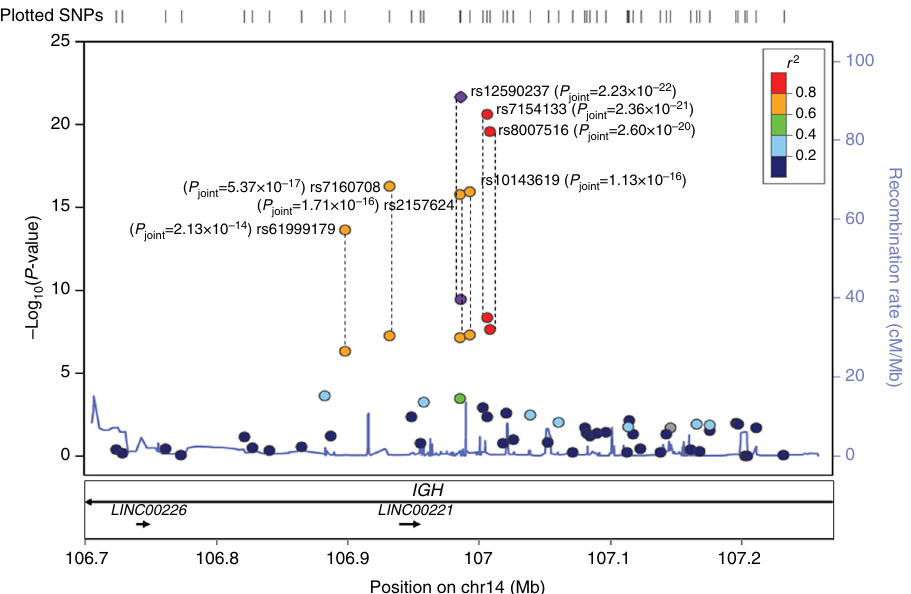
Fig. 2 Regional association plot and linkage disequilibrium (LD) for the IGH loci on chromosome 14. Each SNP is plotted according to its chromosomal location ( x axis) and its -log 10 P -values (left y axis) from the trend test of the primary GWAS scan and joint analysis. The dashed lines connect the same SNPs in the discovery and joint stages. The combined P -value ( P joint ) for genome-wide signi fi cant SNP is labeled next to the dbSNP rsID. The right y axis and blue line showed estimated recombination rates based on the hg19/1000 genomes 2014 ASN version. SNPs are colored to re fl ect its LD (using the r 2 algorithm) with the most signi fi cant SNP (rs12590237,